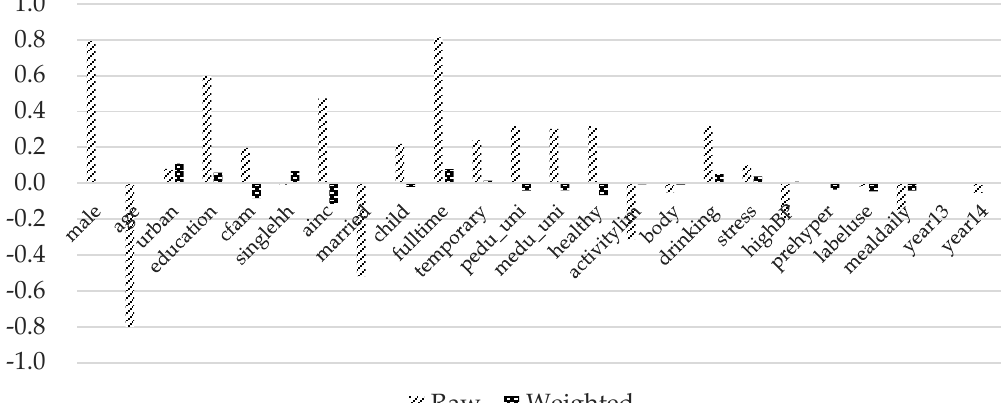
Figure 4. Standardized mean differences of treatment group 2. Note: Detailed explanations of the variables are included in Table 3.